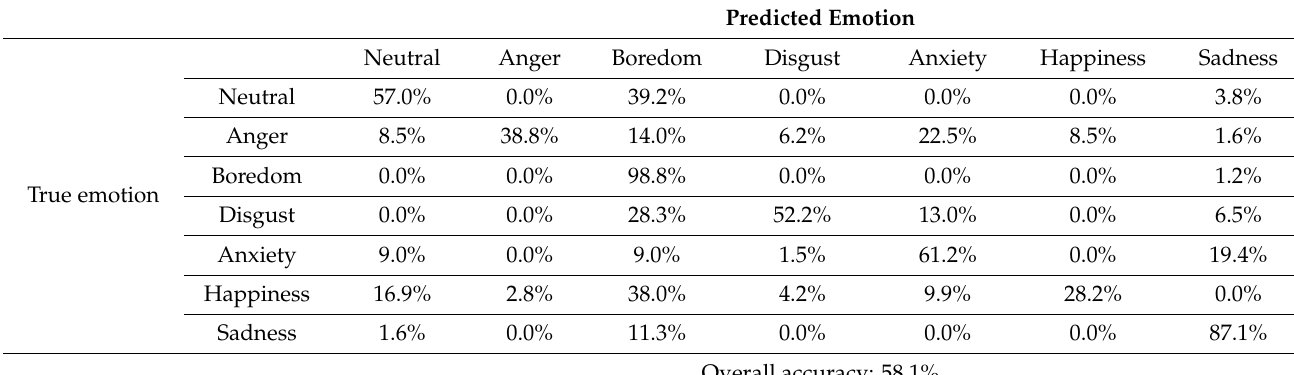
Table 14. Confusion matrix of the emotion classification results of the baseline CNN that was trained on the German EMO-DB mixed with the TMETRO noise.